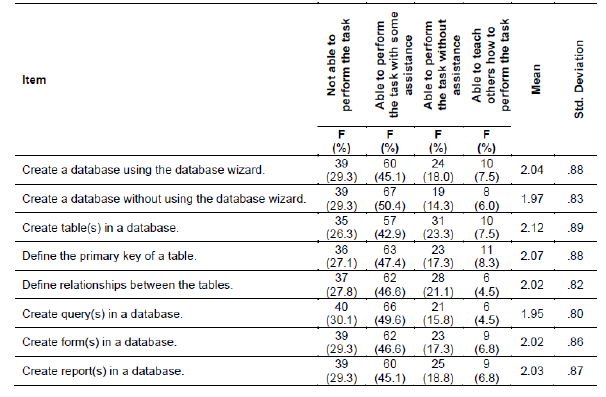
Table 8. Descriptive Statistics for Items on Databases